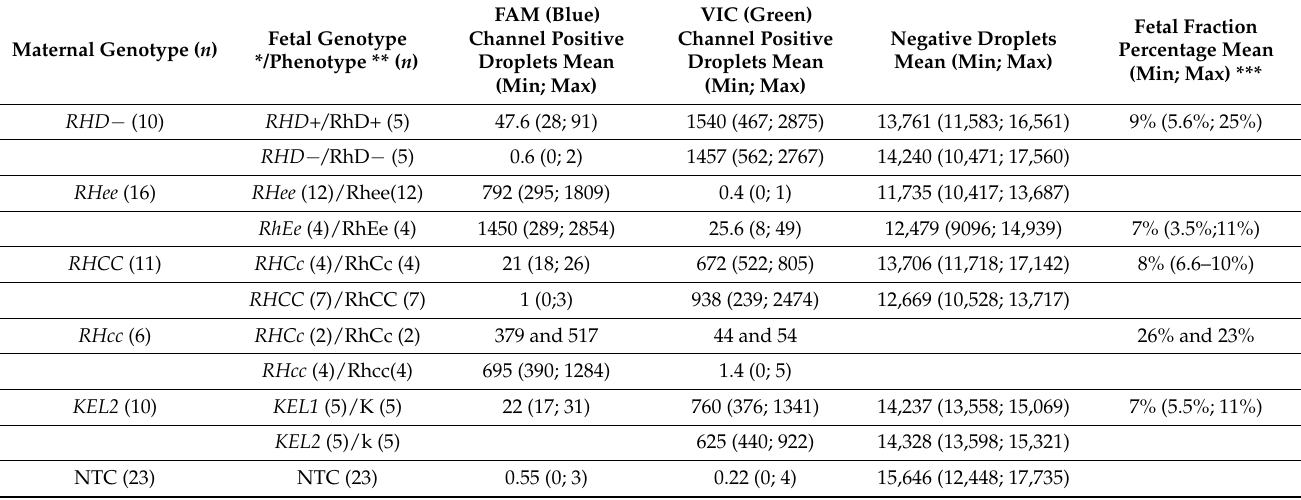
Table 3. Results of RHD, RHCE , and KEL genotyping from maternal cffDNA and basic ddPCR